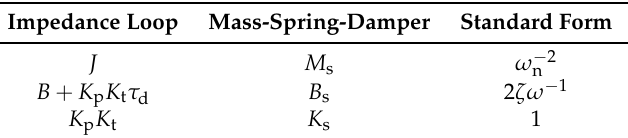
Table 1. Coefficients of the impedance loop, Mass-Spring-Damper and standard 2nd order transfer functions (Equation (1) and